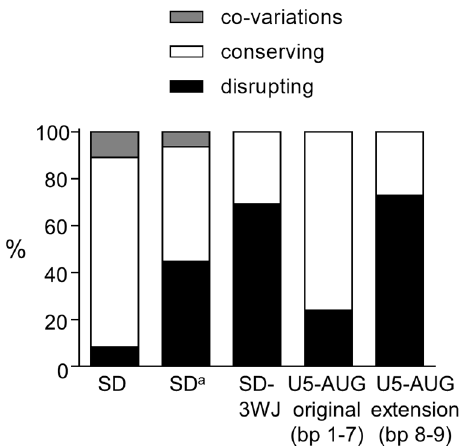
Figure 3. Phylogenetic analysis supports the SD hairpin structure. All nt variations observed in the base paired nts of the SD and SD a hairpins, and the SD-3WJ interaction, U5-AUG duplex (bp 1–4) and U5-AUG duplex extension (bp 5–6) of the 3WJ structure were scored as co-variation (grey bar), as structure conserving (white bar) or as structure disrupting (black bar). Co-variations and double variations were counted as single events. The total frequency of each category is shown.